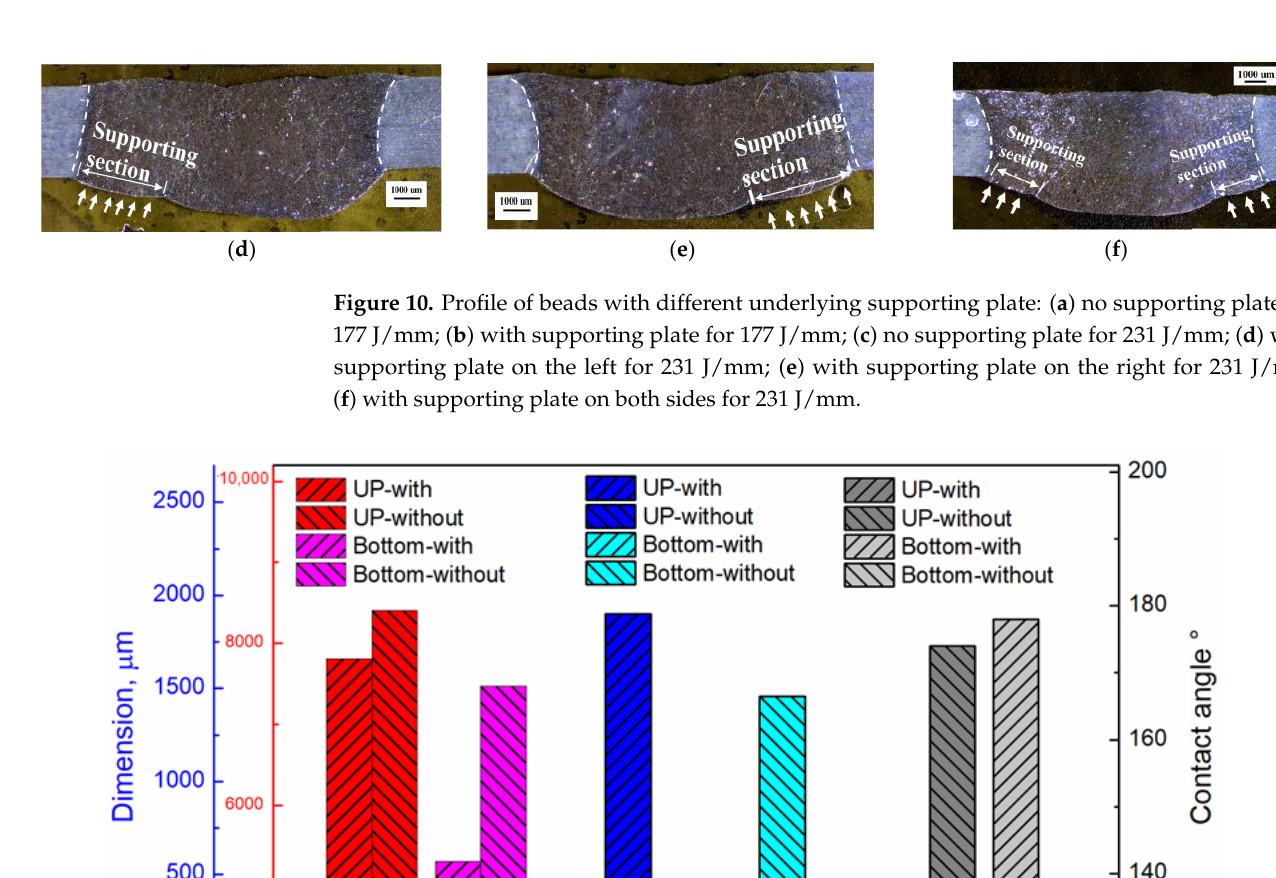
Figure 11. Comparison of bead dimensions with and without supporting plate.